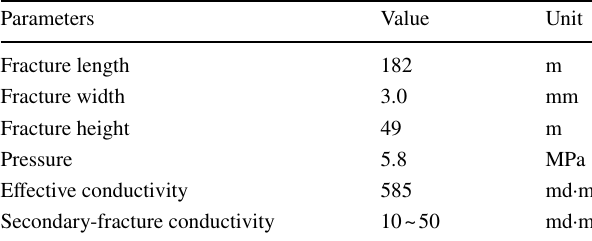
Table 2 Parameters of the first fracturing